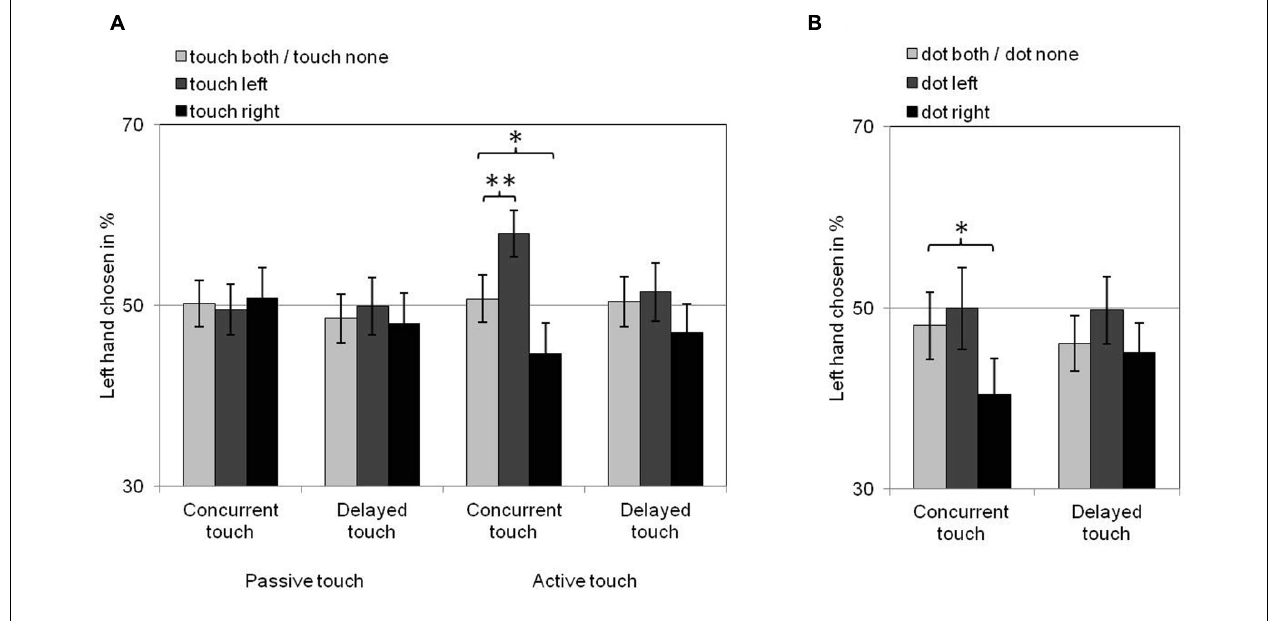
proportions are around chance (50%) when observing touch/dots on both hands or none. Proportions above those reflectVRT effects from observing left hand touch/dots (dark gray bars) and proportions below those reflectVRT effects from observing right hand touch/dots (black bars). Single asterisks denote significant pairwise comparisons at the 0.05 level. Double asterisk indicates significant pairwise comparison at the 0.005